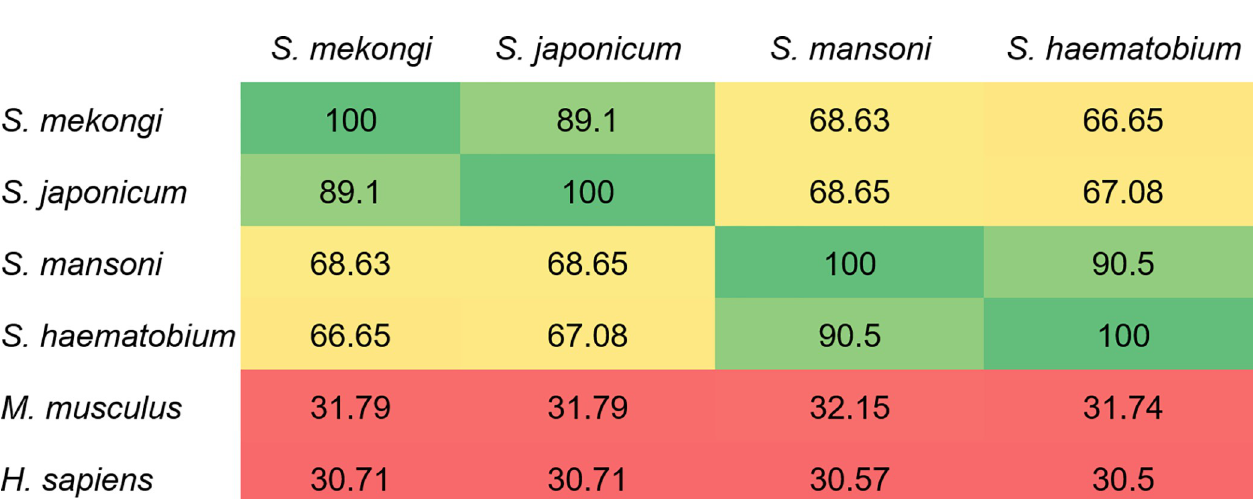
PLOS ONE | https://doi.org/10.1371/journal.pone.0275992 October 13,